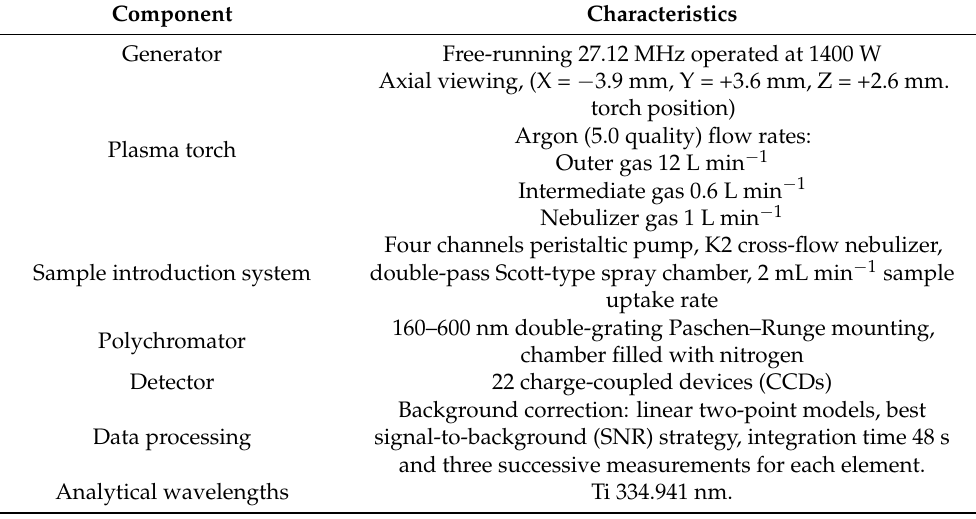
Table 1. Operating conditions for the SPECTRO CIROS CCD spectrometer.